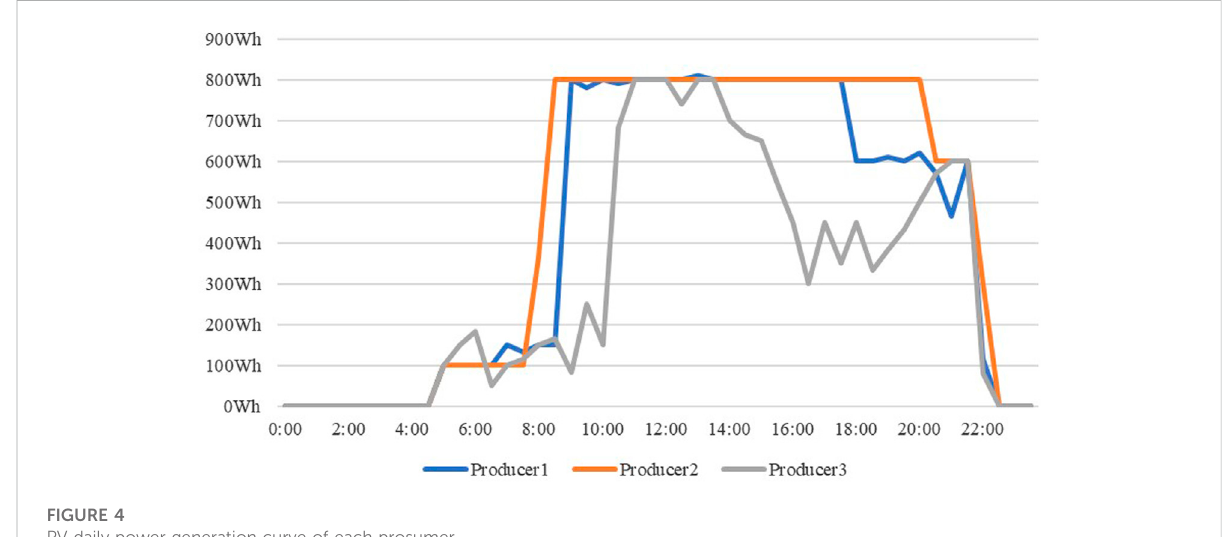
FIGURE 4 PV daily power generation curve of each